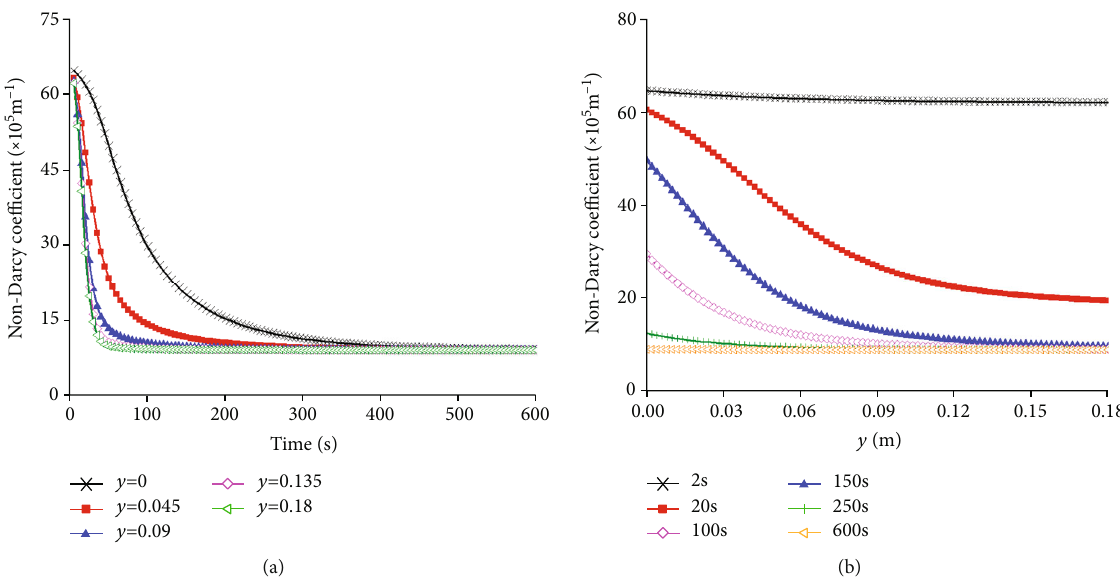
Figure 8: Evolution of the non-Darcy coe ffi cient: (a) over time and (b) with space.